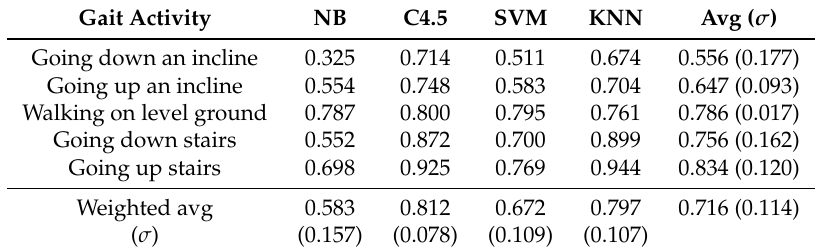
Table 6. F-measures for all gait activities using the best treatment by each classifier from sampled data (Table 5). Gait Activity NB